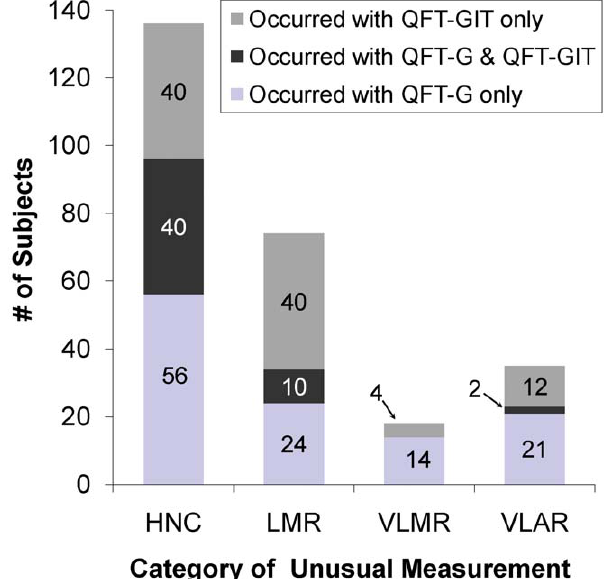
Figure 3. Number of subjects with unusual IFN- c measure- ments when QuantiFERON-TB Gold In-Tube tests were repeat- ed. The number of subjects with unusual IFN- c measurements categorized as High Nil Concentration ( HNC ), Low Mitogen Response ( LMR ), Very Low Mitogen Response ( VLMR ), and Very Low Antigen Response ( VLAR ) that occurred only with the initial test (light gray bars), with the repeat test (dark gray bars), or in both the initial and repeat test (medium gray bars) among 915 subjects with initial and repeat QuantiFERON-TB Gold In-Tube test results.